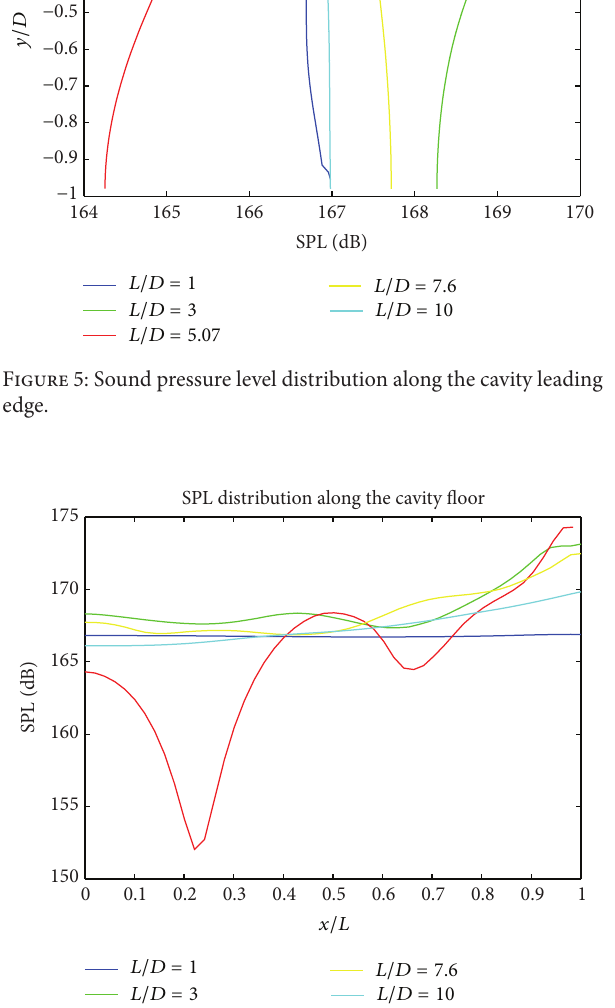
Figure 6: SPL distribution along the cavity floor.